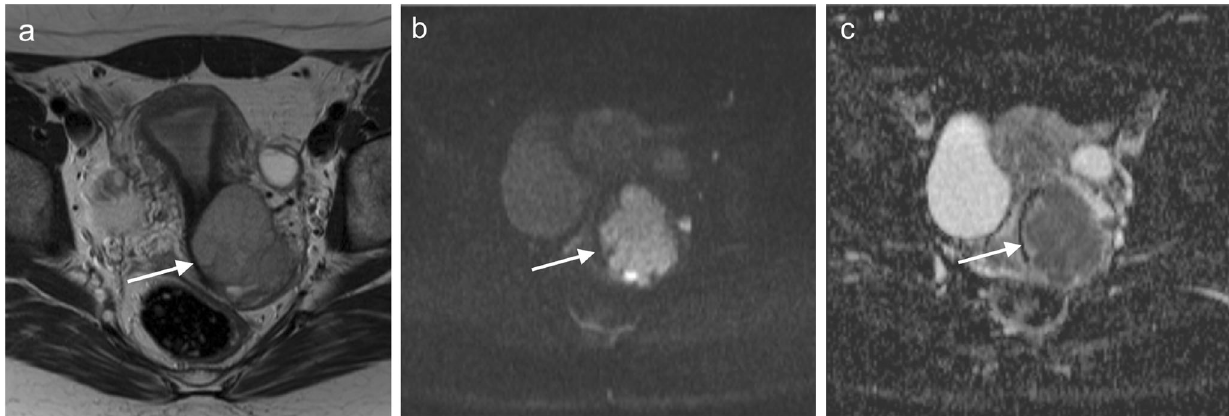
( arrow ), and there is disruption of the cervical stroma ring and parametrical invasion ( a ). The tumour shows high signal intensity on DWI ( b ), with corresponding low signal intensity on the ADC map (